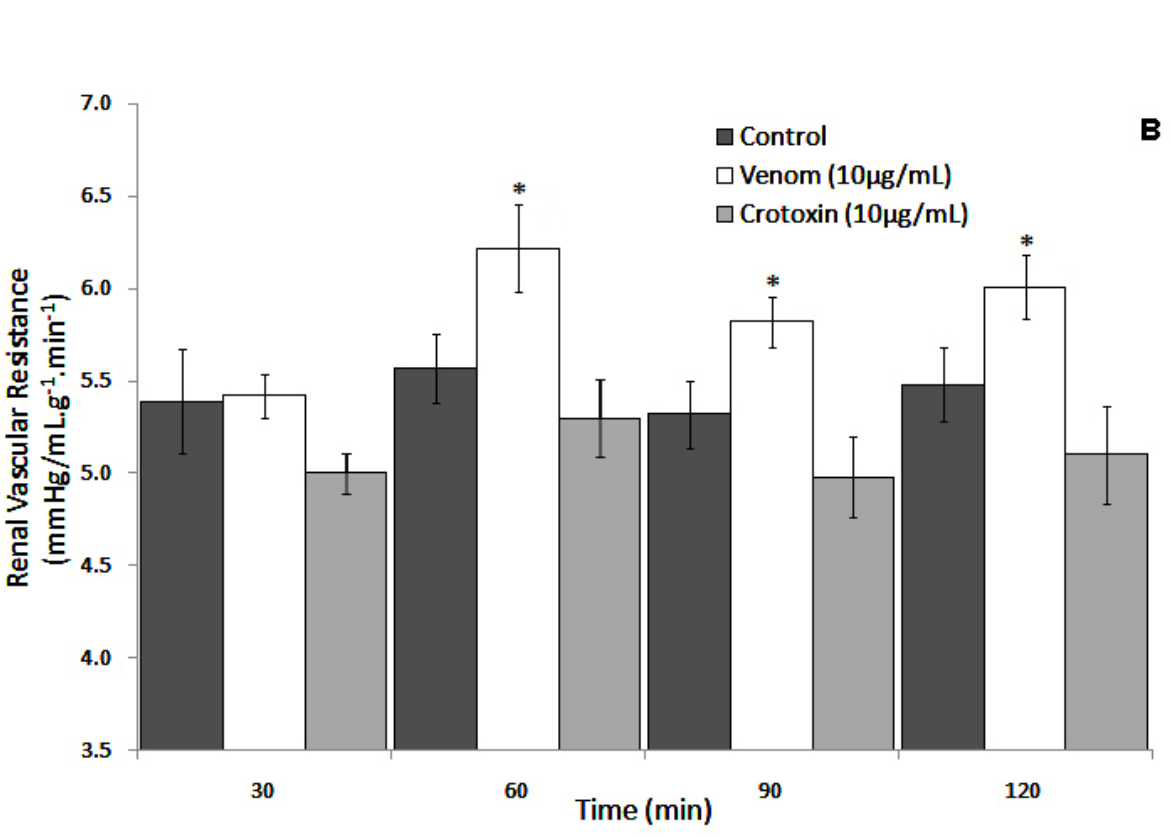
Figure 3. Effects of C. d. cumanensis venom (10 µg/mL) and crotoxin (10 µg/mL) on ( A ) perfusion pressure (PP) and ( B ) renal vascular resistance (RVR).The results are expressed as mean ± SEM, ANOVA, Bonferroni post-test, * p < 0.05, compared to the corresponding control